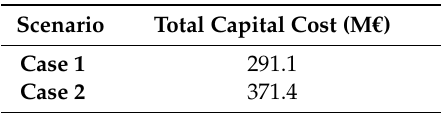
Table 13. Total capital costs associated to the HVDC systems